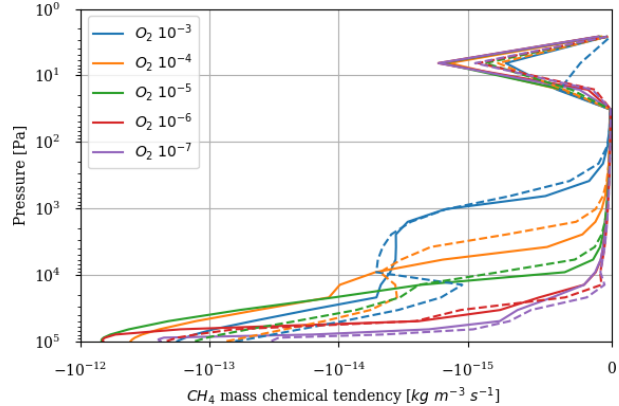
Figure 10. Methane photochemical losses as a function of altitude for several O 2 levels and a surface CH 4 VMR of 10 − 4 . Results from 1D modeling and for a surface temperature of 280K (solid) and 220K